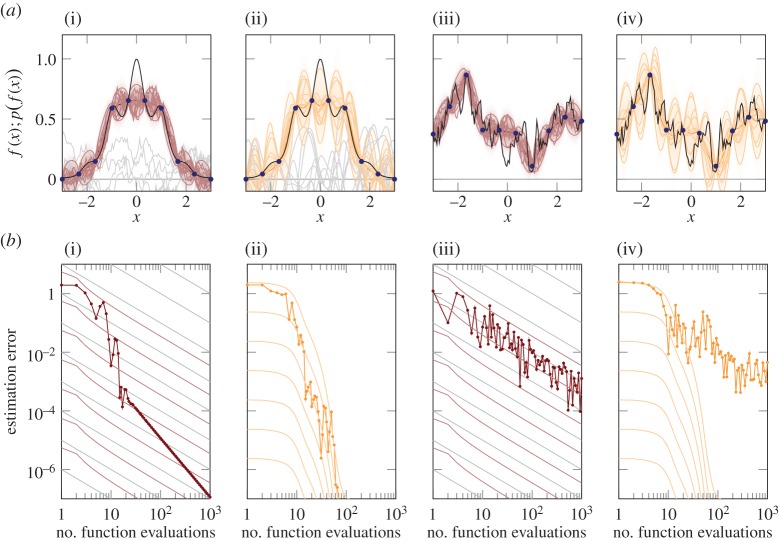
Quadrature rules, illustrating the challenge of uncertainty calibration. (a(i)(ii)) Function, f(x) (black line), is approximately integrated using two different Gaussian process priors (a(i) linear spline; a(ii) exponentiated quadratic), giving posterior distributions and mean estimates. Grey lines are functions sampled from the prior. The thick coloured line is the posterior mean, thin lines are posterior samples and the delineation of two marginal standard deviations. The shading represents posterior probability density. (b(i)(ii)) As the number of evaluation points increases, the posterior mean (thick line with points) converges to the true integral value; note the more rapid convergence of the exponentiated-quadratic prior. The posterior covariance provides an error estimate whose scale is defined by the posterior mean alone (each thin coloured line in the plots corresponds to a different instance of such an estimate). But it is only a meaningful error estimate if it is matched well to the function's actual properties. (b(i)) shows systematic difference between the convergence of the real error and the convergence of the estimated error under the linear spline, whereas convergence of the estimated error under the exponentiated-quadratic prior is better calibrated to the real error. Grey grid lines in the background, bottom left, correspond to O(N−1) convergence of the error in the number N of function evaluations. (a(iii)(iv),b(iii)(iv)) The same experiment repeated with a function f drawn from the spline kernel prior. For this function, the trapezoid rule is the optimal statistical estimator of the integral (note well-calibrated error measure in b(iii)), while the Gaussian kernel GP is strongly over-confident.